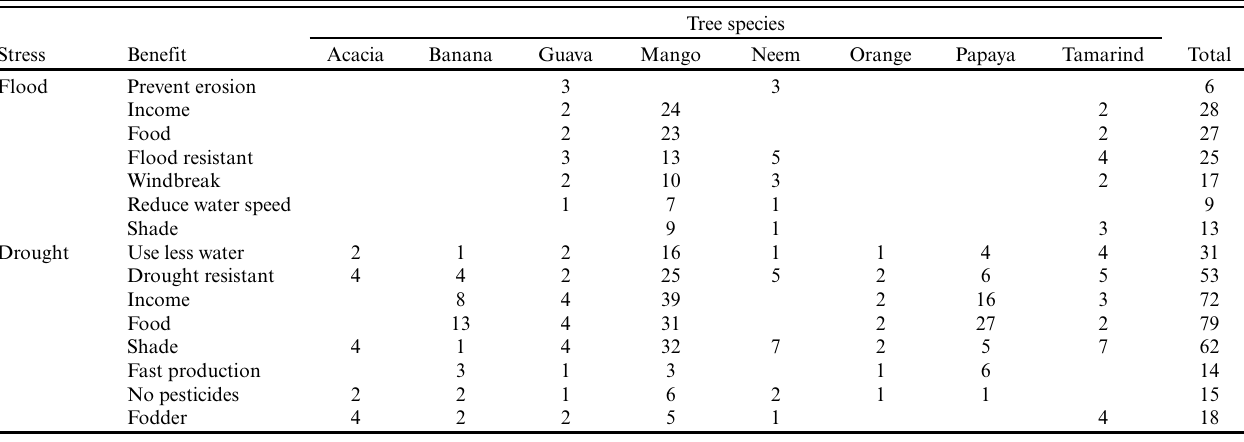
Table 3. Tree species listed and the reasons given for their performance and benefits during floods and drought. Numbers indicate the number of household case study interviewees that named that specific tree and the corresponding specific benefit. Case study interviewees freely listed tree species as well as reasons why that specific tree does well during floods or drought. Only tree species named > 10 times are